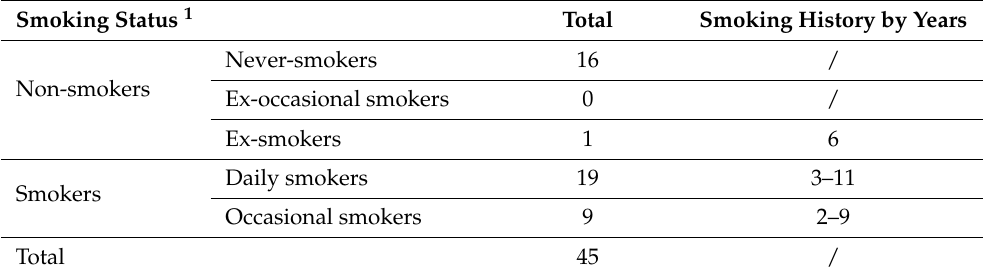
Table 2. Smoking status and history in